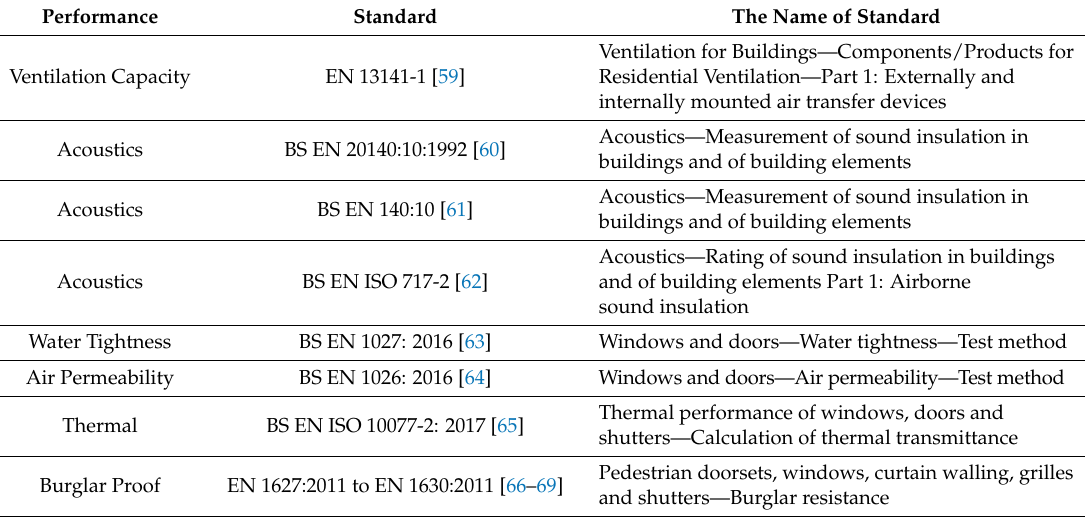
Table 3. The Standards which are used to determine Trickle Vent performance